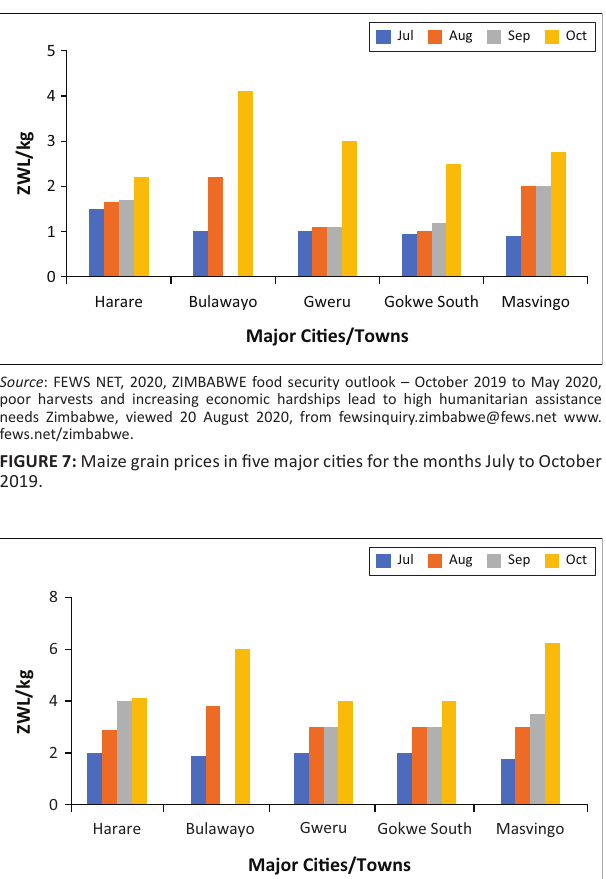
FIGURE 8: Maize meal prices in five major cities for the months July to October 2019.